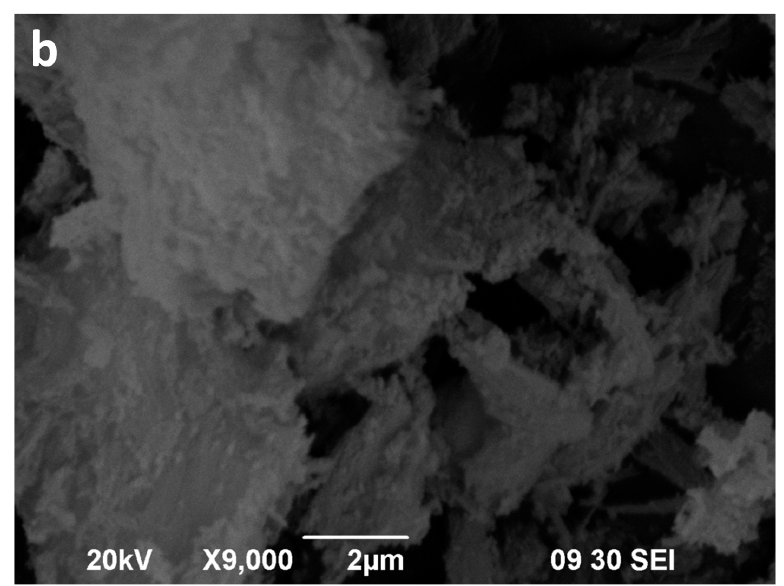
Figure 10. SEM images of the sepiolite Sp1 ( a ), sepiolite Sp1 after 16 min of microwave-assisted acid treatment ( b ).